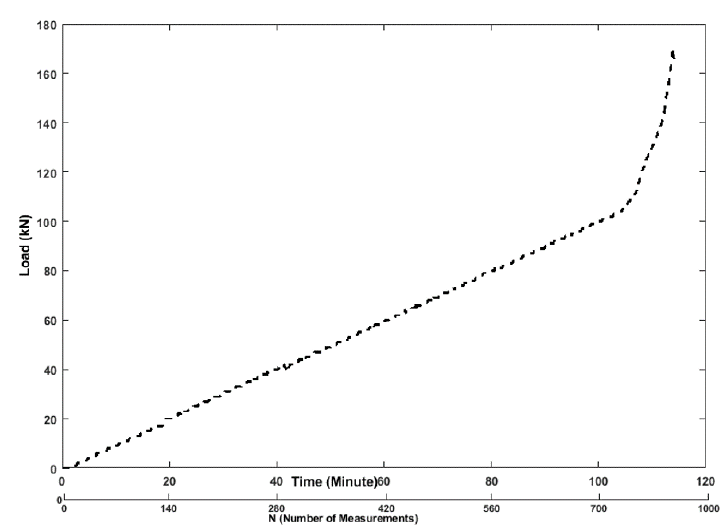
Figure 6. Loading schedule vs. number of ultrasonic measurements.